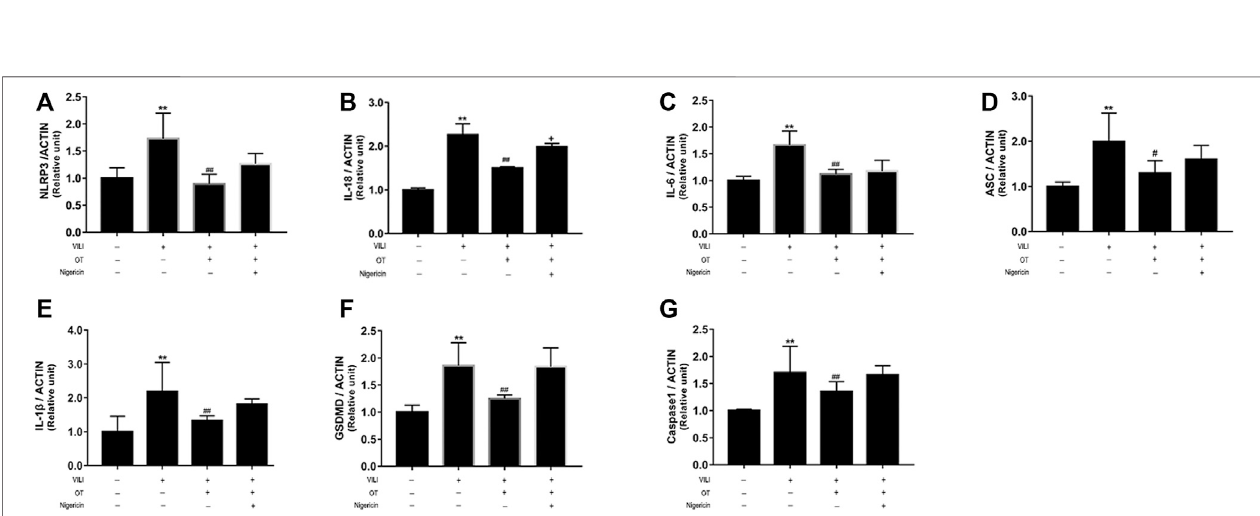
FIGURE9| Effects ofoxytocinontheexpression ofNLRP3,IL-18,IL-6, ASC,IL-1 β ,GSDMD,and Caspase-1 inlung tissues fromVILImice treatedwithorwithout Nigericin.RT-qPCR is performed to evaluate the expression of the NLRP3 (A) , IL-18 (B) , IL-6 (C) , ASC (D) , IL-1 β (E) , GSDMD (F) , and Caspase-1 (G) mRNAs in lung tissues from mice exposed to mechanical ventilation in the presence or absence of Nigericin. Data are presented as the means ± SD ( n (cid:2) 5). * p < 0.05, and ** p < 0.01 compared with the Control group; # p < 0.05 and ## p < 0.01 compared with the VILI group. OT, oxytocin; SD, standard deviation; VILI, ventilation-induced lung